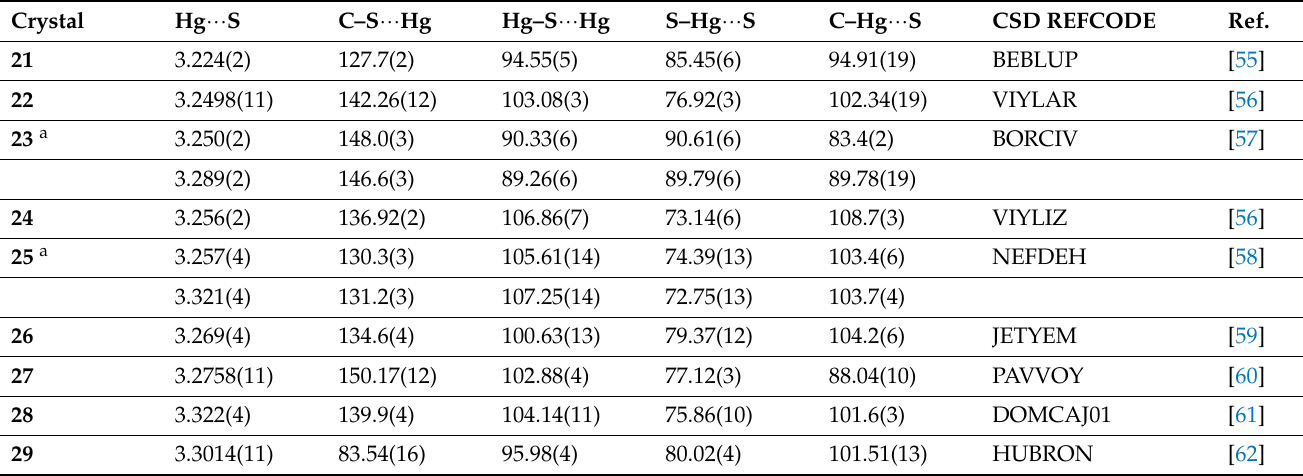
Table 2. Summary of geometric parameters (Å, ◦ ) for 21 – 29 , each featuring a { ··· HgS} 2 synthon in their